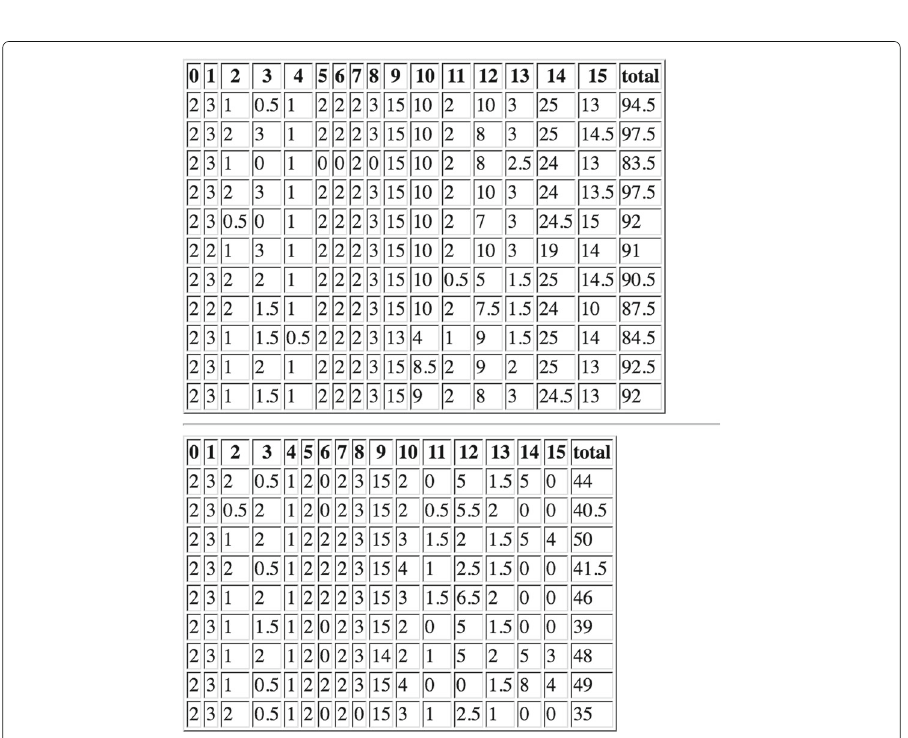
Fig. 7 Clustering results of the k-means